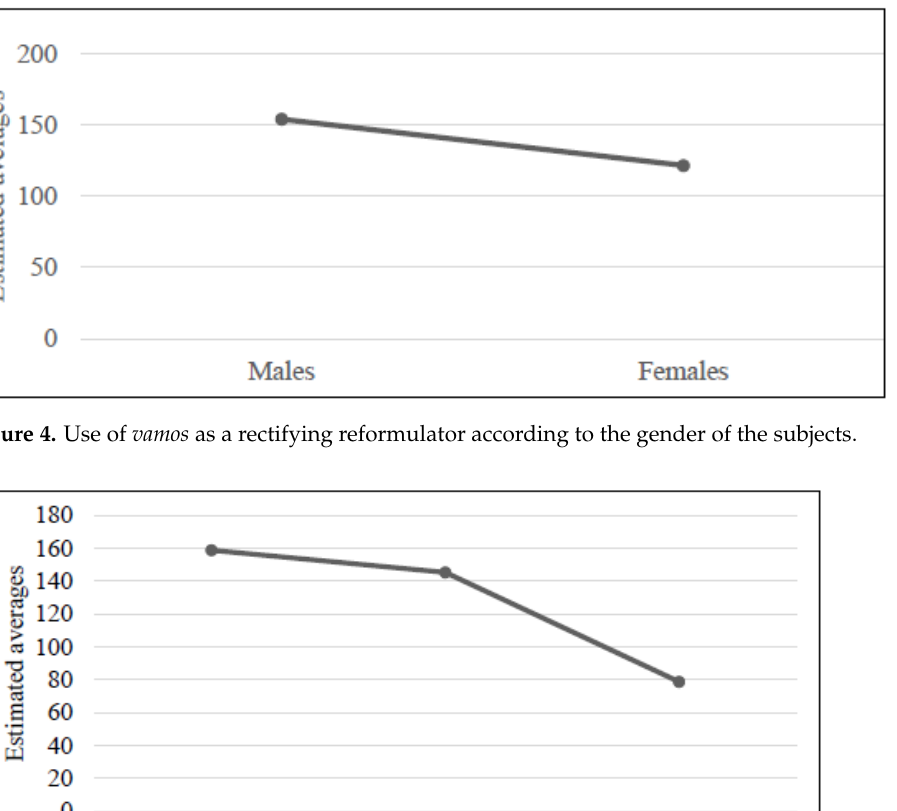
Figure 4. Use of vamos as a rectifying reformulator according to the gender of the subjects.